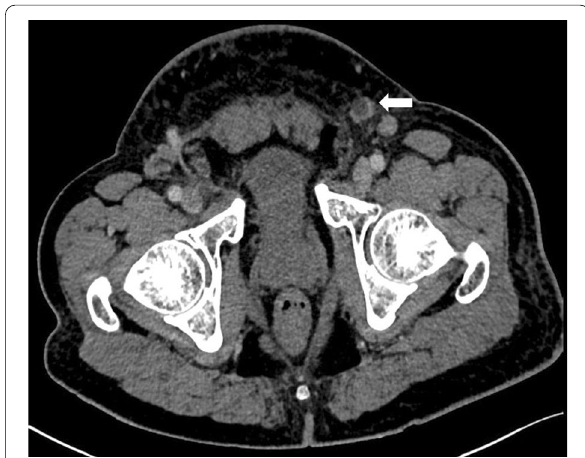
Fig. 3 CT axial image showing a discrete node with cystic changes in left inguinal region (white arrow)